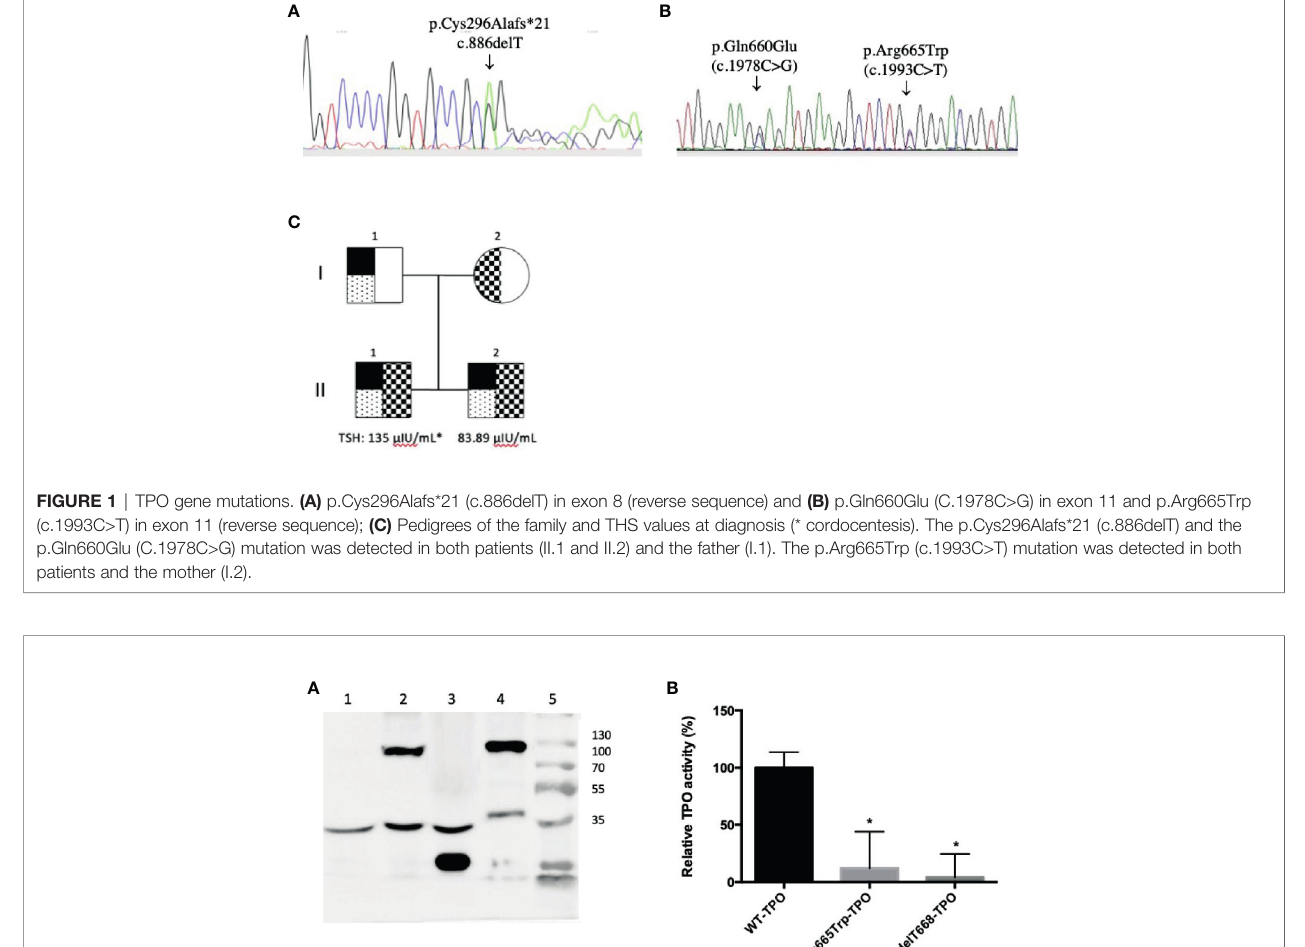
FIGURE 2 | (A) Western blot of HEK293 extracts from cells transfected with wild-type or mutant TPOs. Lane: 1) pCDNA 3.1; Lane 2) Arg665Trp-TPO, 103 kDa; Lane 3) delT668-TPO, 35 kDa; Lane 4) TPO-WT; 103 kDa; Lane 5) molecular weight marker Thermo Scienti fi c Page Ruler (Thermo Scienti fi c, Carlsbad, CA). All strains expressed the endogenous control alpha-tubulin (53 kDa). (B) Extracellular enzymatic activity of HEK293 cells expressing wild-type or mutant TPOs. Enzymatic activity was assessed using the Amplex UltraRed reagent. l EXCITATION = 530 nm and l EMISSION = 560 nm. The values are expressed as a percentage of the TPO-WT transfected cells ’ activity (*p <